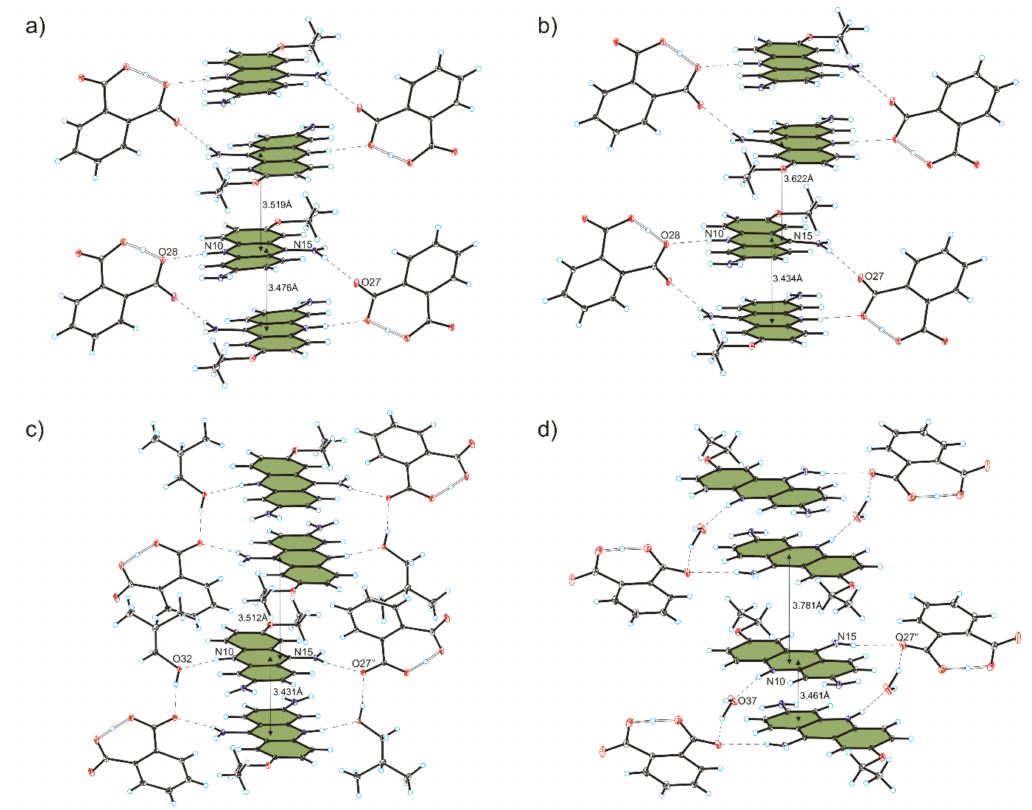
Figure 2. Heterotetramers in compounds 1 – 2 and heterohexamers in compounds 3 – 4 shown in ( a , b ), and ( c , d ),